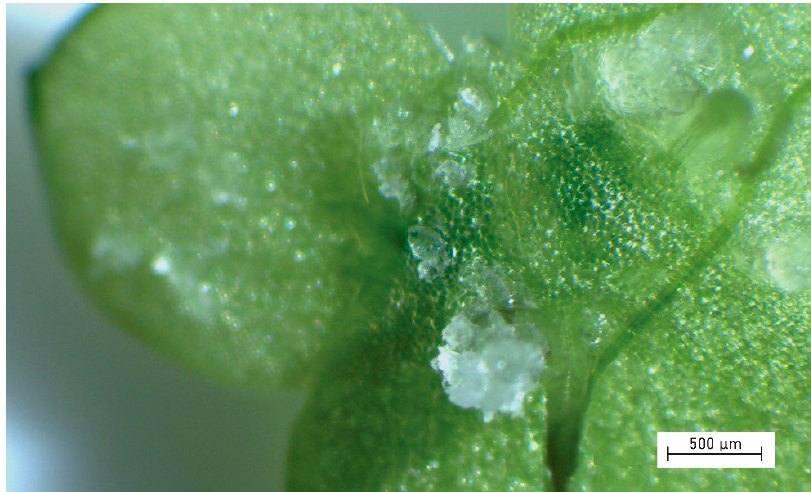
Figure 3. Microbeads adhered to fronds of duckweed.